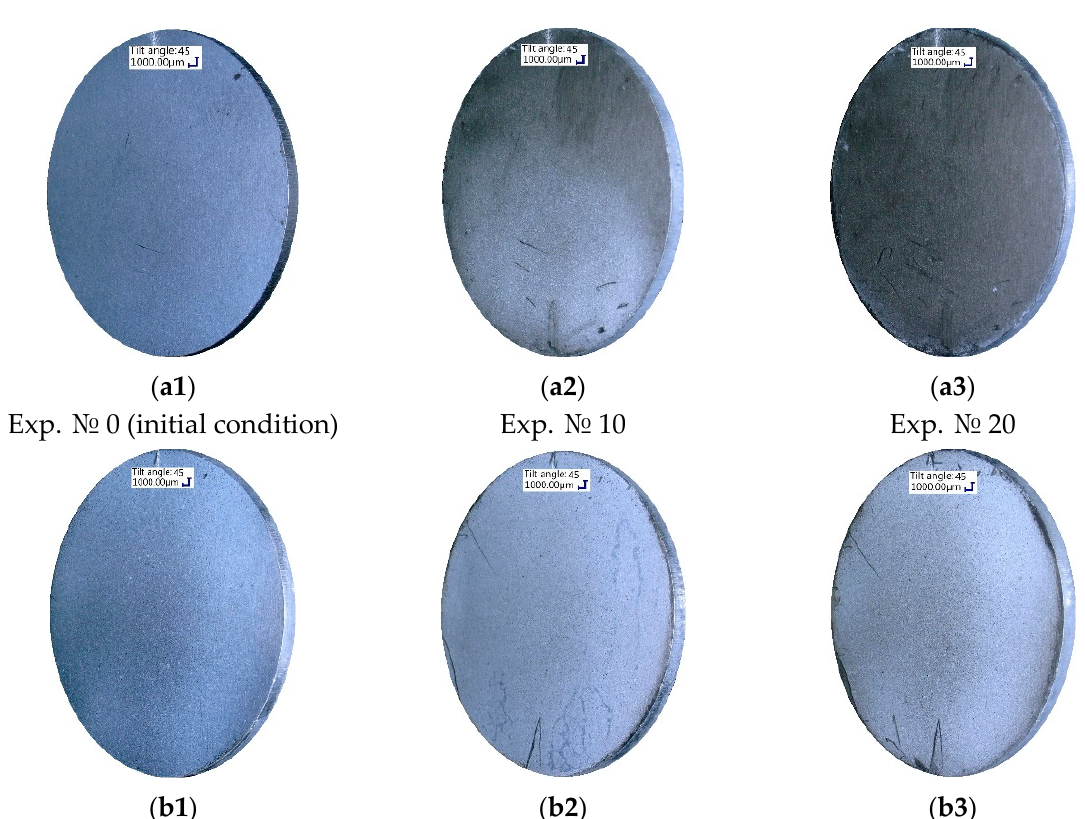
Figure 8. Microscope images at 45° observation angle for the ( a ) old-coated O1 and ( b ) new-coated N1 samples, taken after the experiment number Exp. № 0, № 10, and № 20.